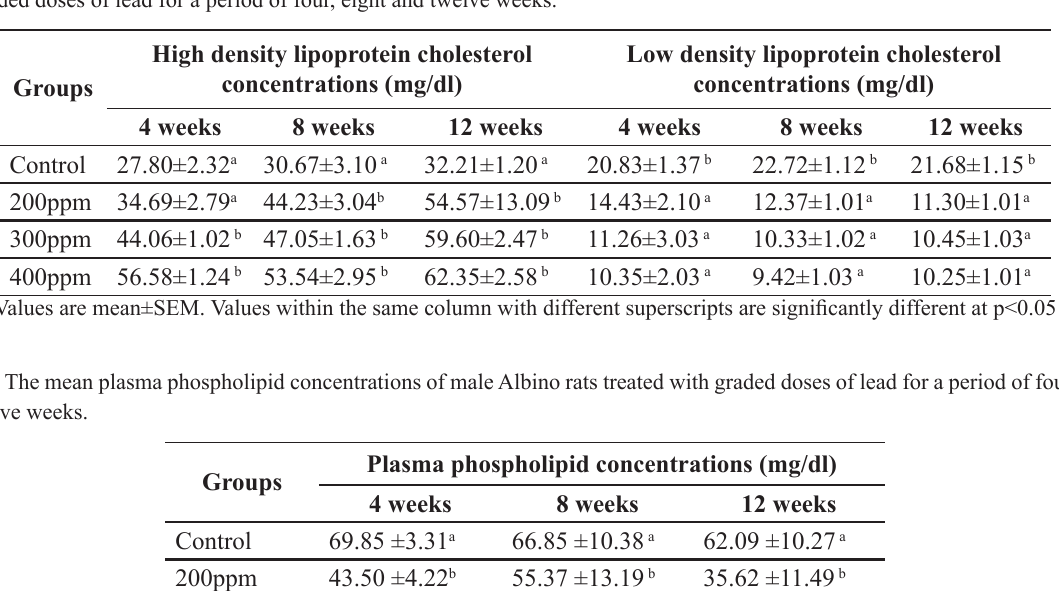
Table 3: The mean plasma high density lipoprotein and low density lipoprotein cholesterol concentrations of male Albino rats treated with graded doses of lead for a period of four, eight and twelve weeks.